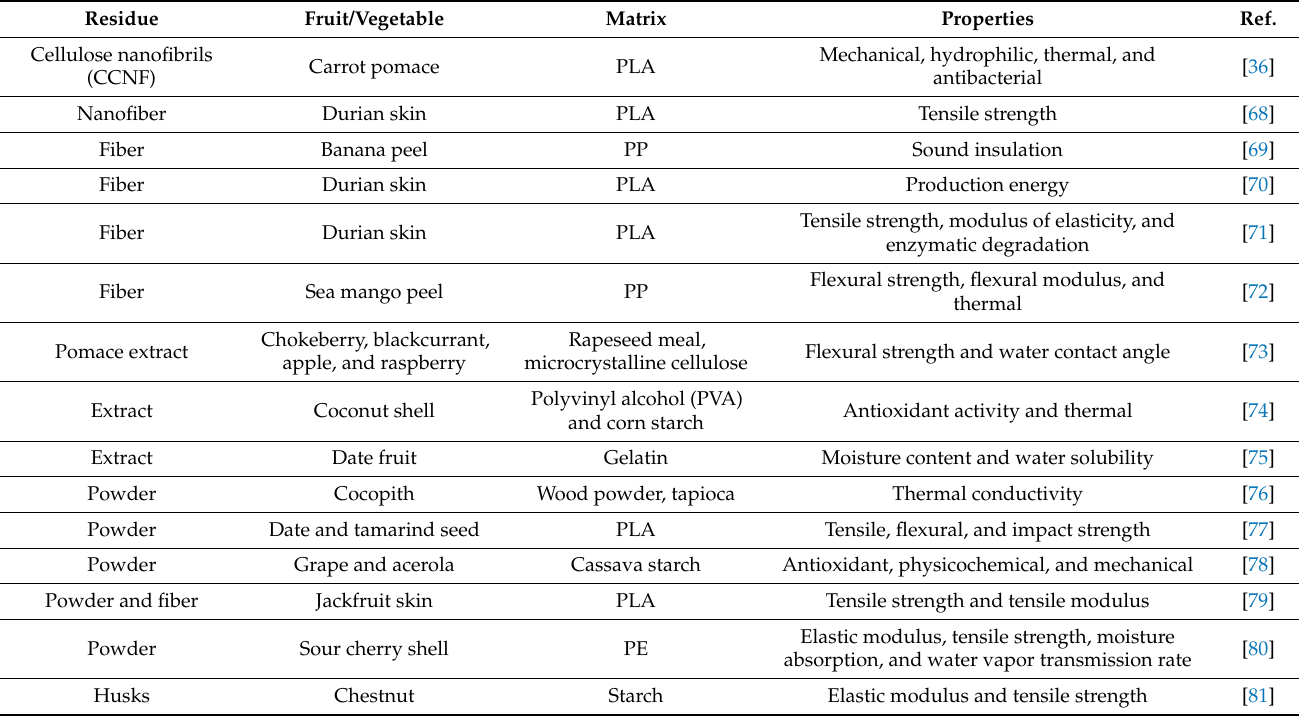
Table 3. Residues derived from fruit and vegetable